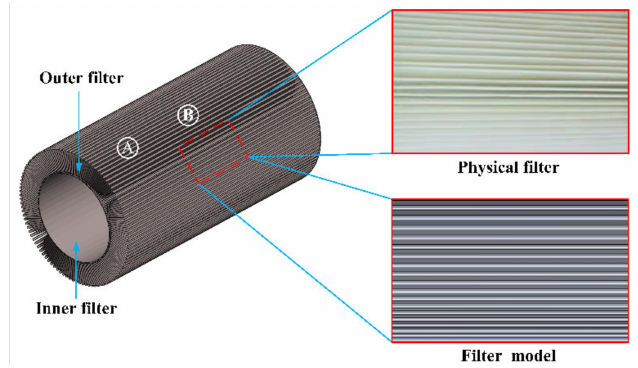
Figure 4. Geometric model of filter